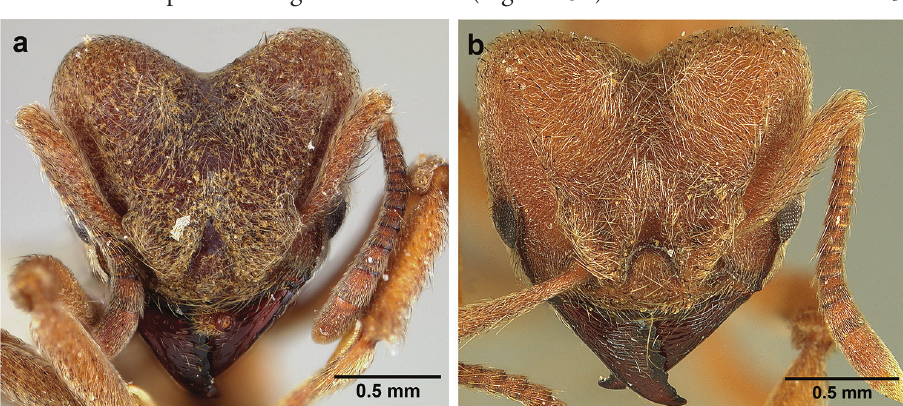
Figure 13. S. lutzi and S. mayri. a S. lutzi head, full-face view b S. mayri head, full-face